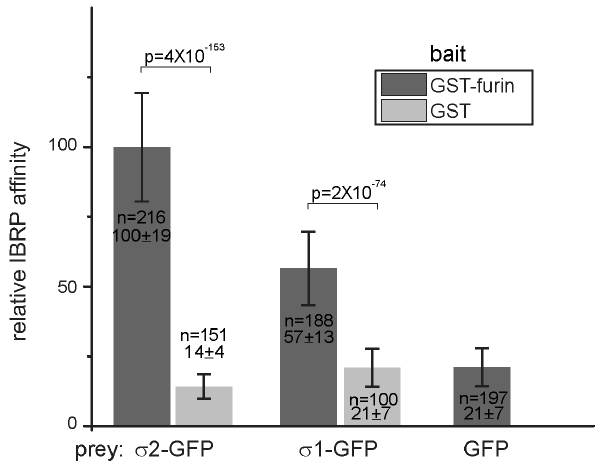
Figure 5. Studying the interaction between furin cytosolic domain and clathrin adaptor proteins AP1 and 2 using IBRP assay. The bead immobilized GST-furin (2 m g/ m l) or GST (3 m g/ m l, as a negative control) were served as baits to pull down cell lysate containing s 2-GFP, s 1-GFP and GFP (as a negative control). The relative IBRP affinities were calculated and plotted. GST-furin, but not GST, selectively binds s 2-GFP and s 1-GFP. Error bars represent standard deviations. n indicates the number of beads quantified. p indicates the p value of selected pair calculated by t-test.